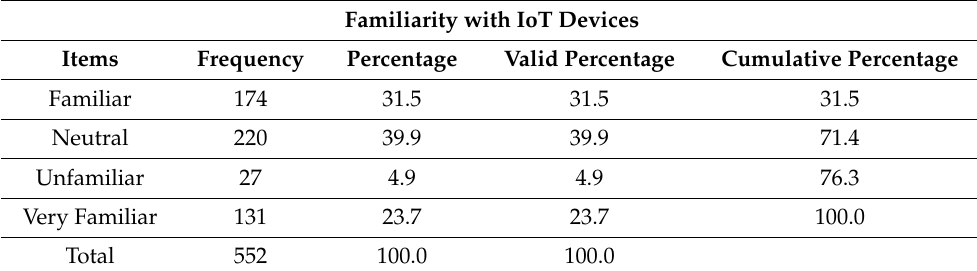
Table 5. Demographic information of the respondents by familiarity with IoT